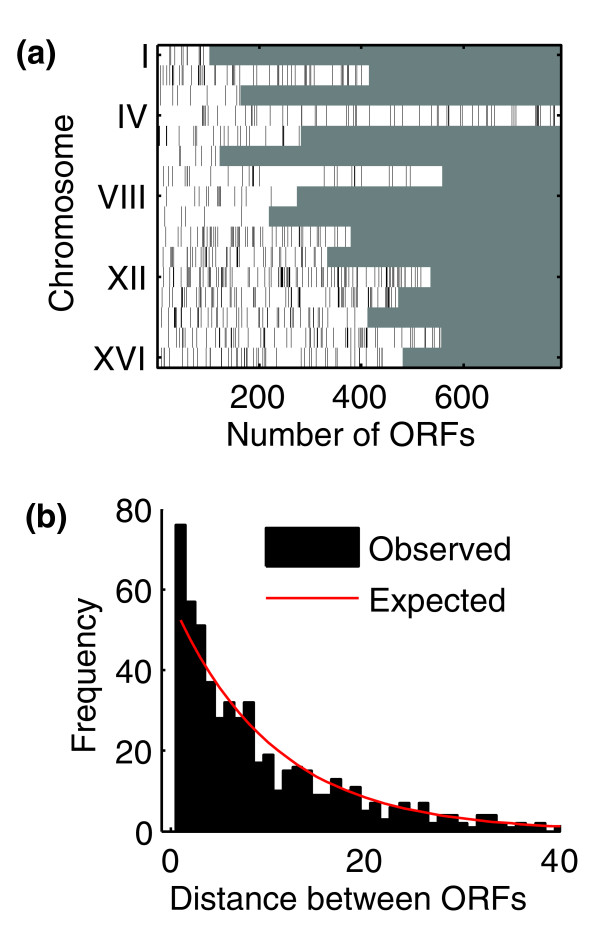
Chromosomal position of the genes in cluster 1. Shown are genes at (a) the chromosomal level and (b) at the local level between ORFs. The 16 chromosomes in panel (a) are shown in white and cluster members as vertical black bars on the chromosomes. The length of the chromosomes are scaled according to the number of ORFs on a given chromosome. (b) The distance between ORFs from cluster 1 (x-axis) measured in number of ORFs. The expected distance is shown with a red curve while the actual distance between ORFs is shown with black bars. ORF, open reading frame.